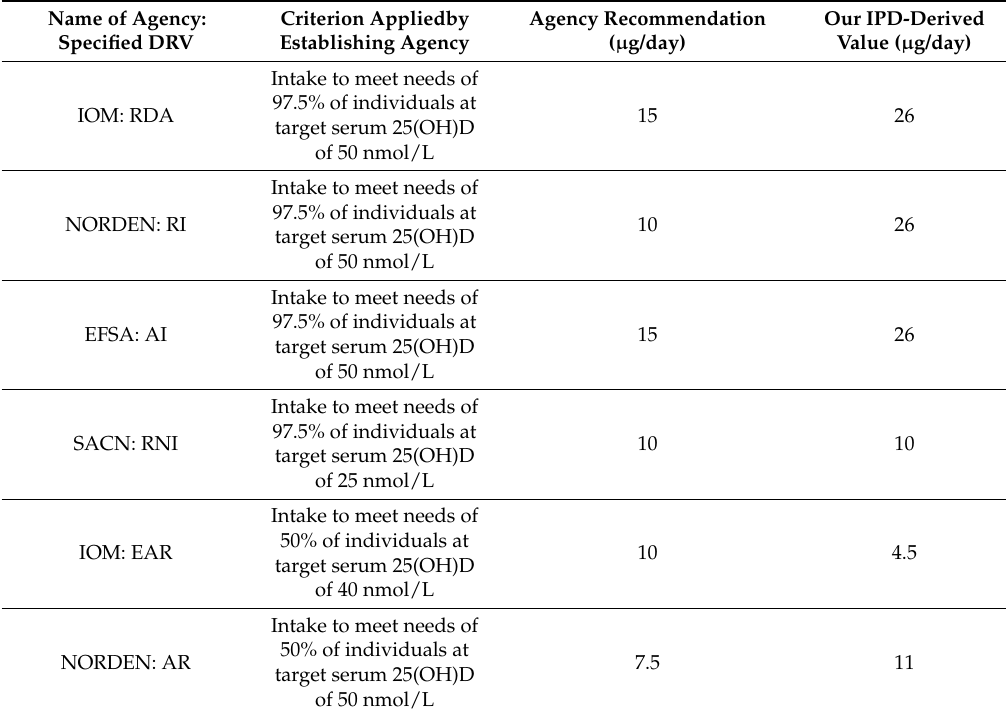
Table 3. Comparison of recent international DRVs with new empirical data from the present two-step IPD analyses using one of the best collections of RCT data available (total n = 882